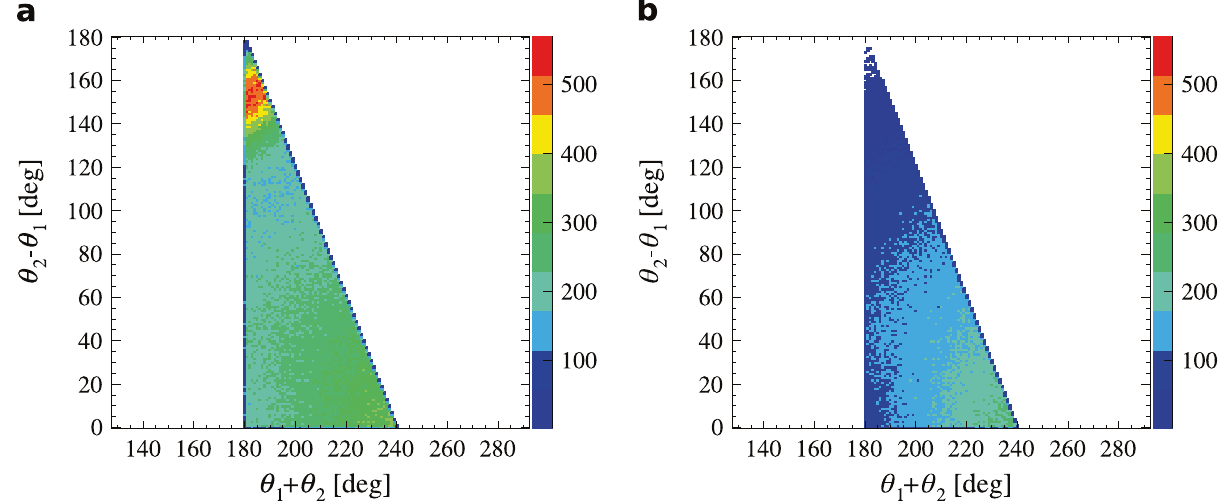
Fig. 5 Effect of secondary Compton scatterings ’ rejection. Relative distribution of the sum and difference of the two smallest angles between photon momenta (see Fig. 3) in the identi fi ed 3 γ events before ( a ) and after ( b ) rejection of the secondary scattered photons. The θ 1 + θ 2 > 180 ∘ limit results from momentum conservation in o-Ps → 3 γ annihilations. o-Ps annihilation events are expected in the right corner of the populated region 55 , whereas the topmost region is speci fi cally for secondary scattered photon events. modules.